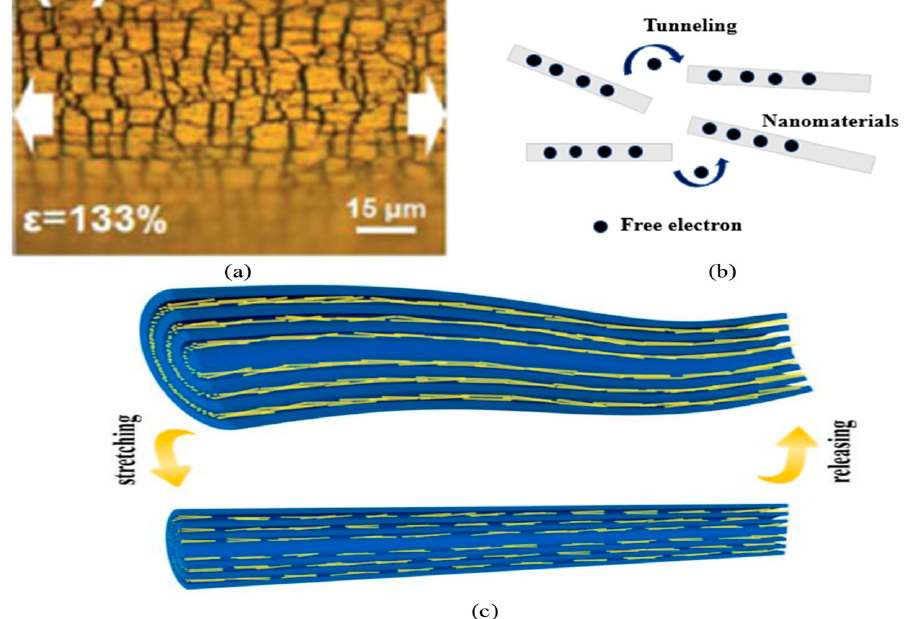
Figure 1. ( a ) Atomic force microscope image of crack formation on Au thin-film-coated PU cord. Reprinted with permission from Ref. [40]. Copyright 2017, Royal Society of Chemistry. ( b ) The transition of free carriers among conducting materials through the non-conducting barrier. ( c ) A schematic to illustrate disconnection and reconnection of nanowires in conductive fibers on stretch and release, respectively. Reprinted with permission from Ref. [27]. Copyright 2021, Elsevier.